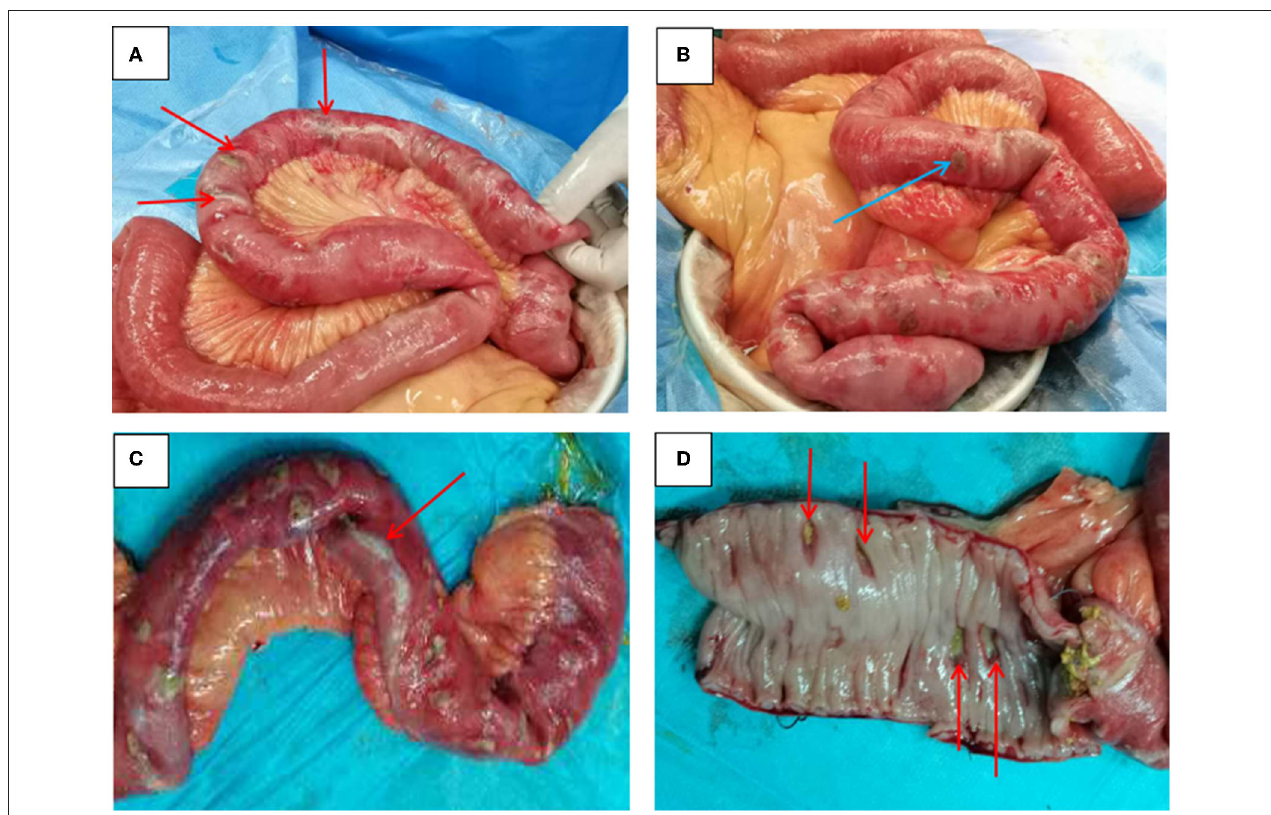
FIGURE 2 | Intraoperative findings. (A) Ileum perforation (red arrow) with no discreet mass lesion; (B) Perforation of the ileum ∼ 30cm from the ileocecal region and about 40cm in size (blue arrow); (C) A large amount of purulent discharge (red arrow) was found in the intestinal wall and the perforation focus; (D) Ulcers (red arrow) were seen in the ileum mucosa and have penetrated different levels, including the full thickness of the bowel